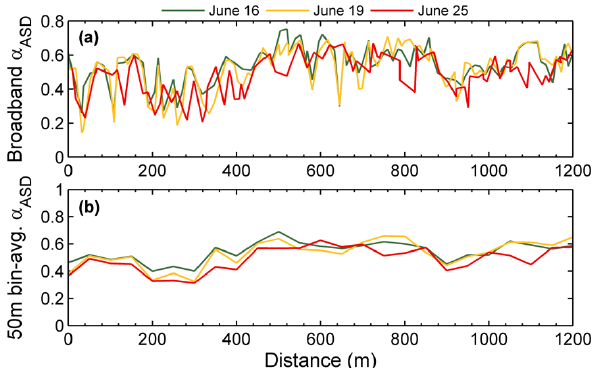
Figure 3. High-quality daily average broadband α MOD Pixel 1 and α MOD Pixel 2 , α base (for SZA <70 ◦ ), and α MOD Pixel 1 and α MOD Pixel 2 time series for the 2013 melt season. α ASD Pixel 1 and α ASD Pixel 2 pixel-averaged values correspond to high-quality ASD transect dates 16, 19, and 25 June. Grey shaded regions show likely snowfall